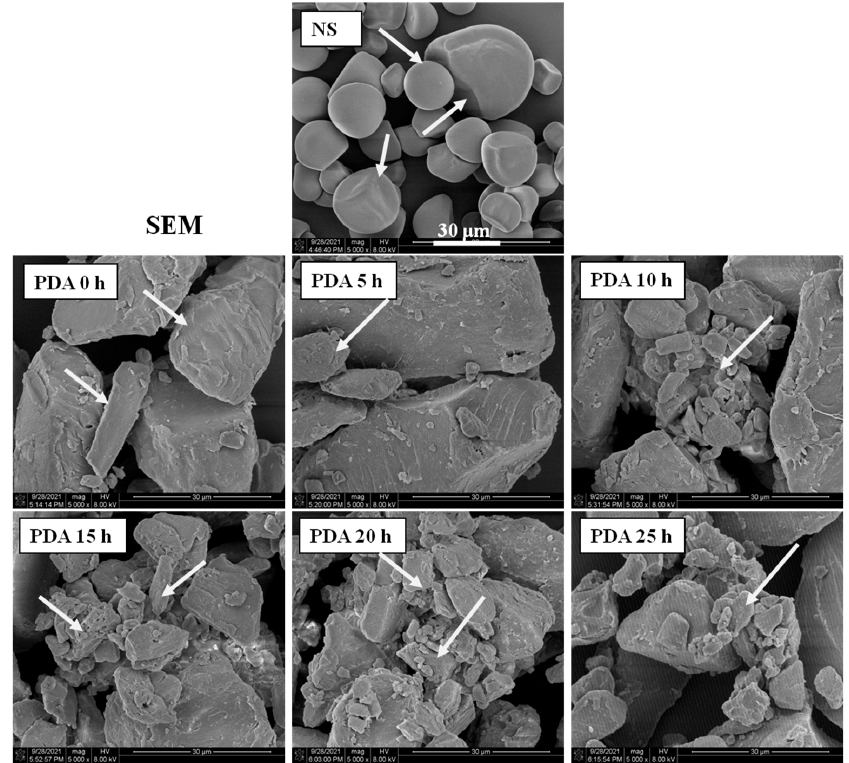
Figure 1. Scanning electron microscopy (SEM) images of native (NS) and debranched in different treatment times combined with autoclaved starches (PDA 0 h, PDA 5 h, PDA 10 h, PDA 15 h, PDA 20 h, and PDA 25 h). The magnification of images was 5000.